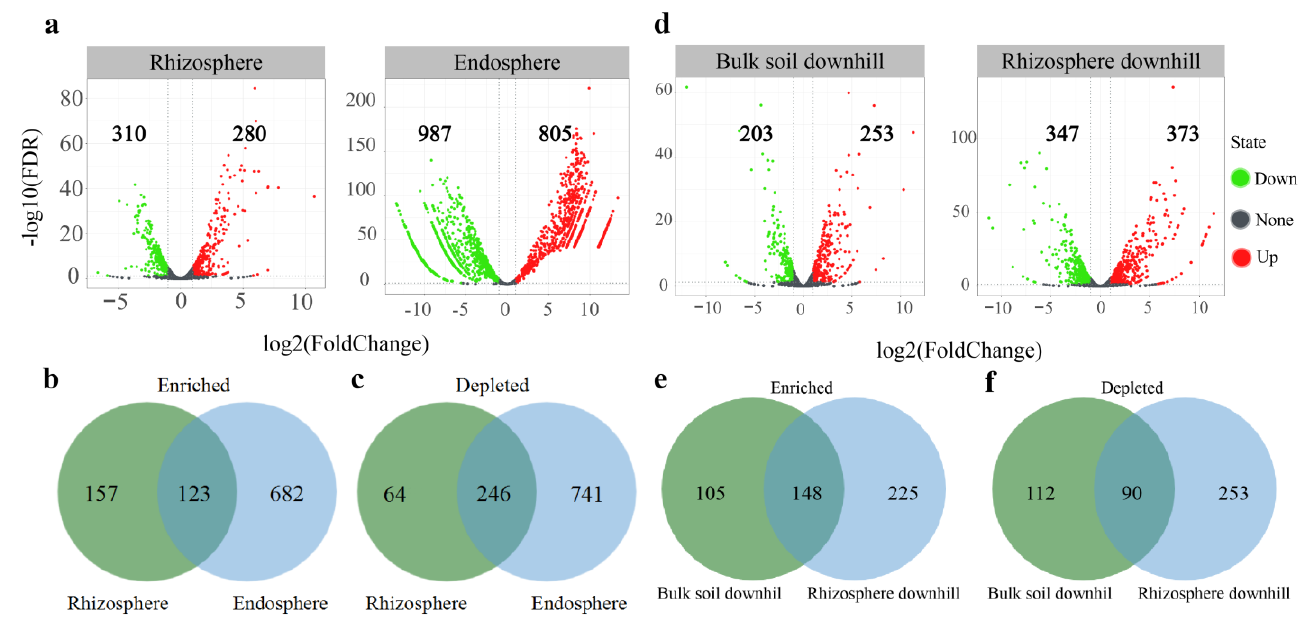
Figure 5. Enriched and depleted OTUs in the root endosphere, rhizosphere, downhill bulk soil, and downhill rhizosphere. ( a ) Bulk soil was used as the control for differential abundance analysis. ( b ) Numbers of differentially enriched OTUs between root endosphere and rhizosphere. ( c ) Numbers of differentially depleted OTUs between endosphere and rhizosphere. ( d ) Uphill bulk soil and rhizosphere were used as controls for differential abundance analysis. ( e ) Numbers of differentially enriched OTUs between downhill bulk soil and rhizosphere. ( f ) Numbers of differentially depleted OTUs between downhill bulk soil and rhizosphere. Each point represents an individual OTU, and the position along the X -axis represents the abundance fold change compared to bulk soil. The Y -axis is -Log 10 (FDR) obtained by correcting the p -value of the significant difference. The closer the point is to the top of the graph, the more significant the difference is.